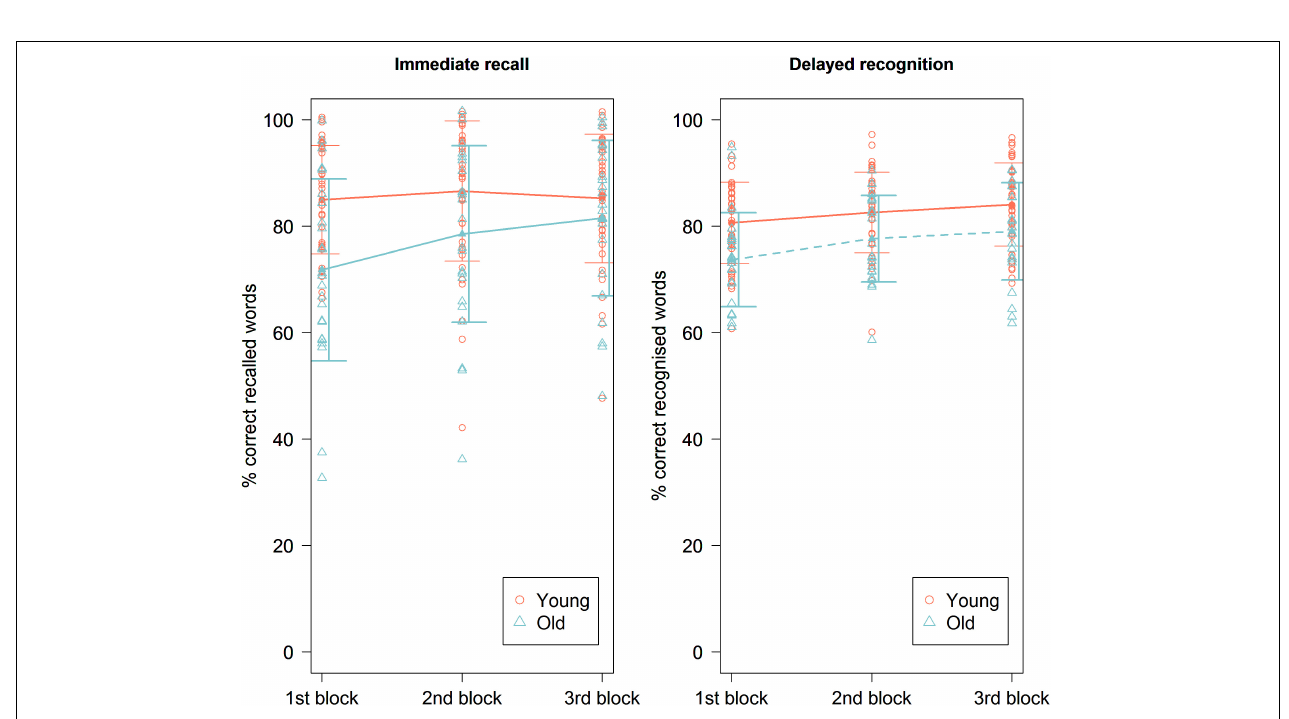
FIGURE 2 | Immediate recall (left) and delayed recognition (right) accuracy scores in percentage for the three experimental conditions for the young and old age group. There was no significant effect of experimental condition on immediate recall and delayed recognition scores in both age groups. Line plots represent mean scores. Error bars represent standard error.